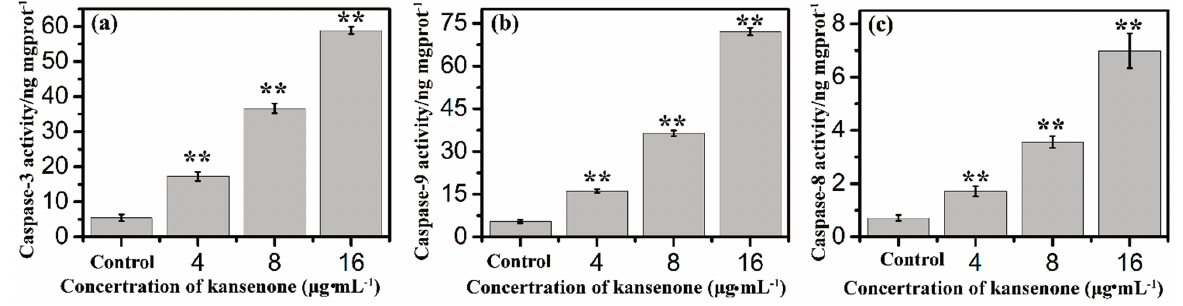
Figure 10. Effects of kansenone on ( a ) caspase-3; ( b ) caspase-9 and ( c ) caspase-8 activity after treatment with kansenone for 48 h. Compared with corresponding control group, ** p <